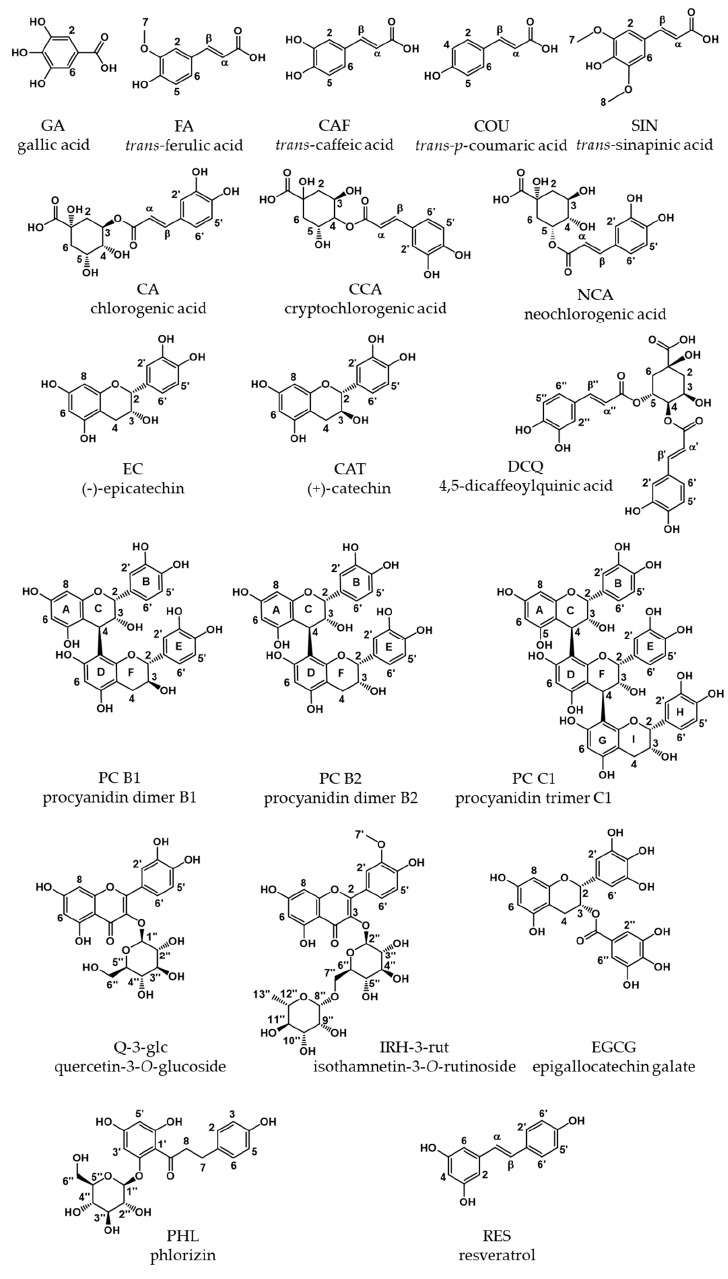
Figure 1. Overview of phenolic compounds investigated.